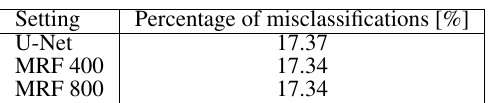
Table 2. Percentage of misclassifications from test data semantic segmentation.